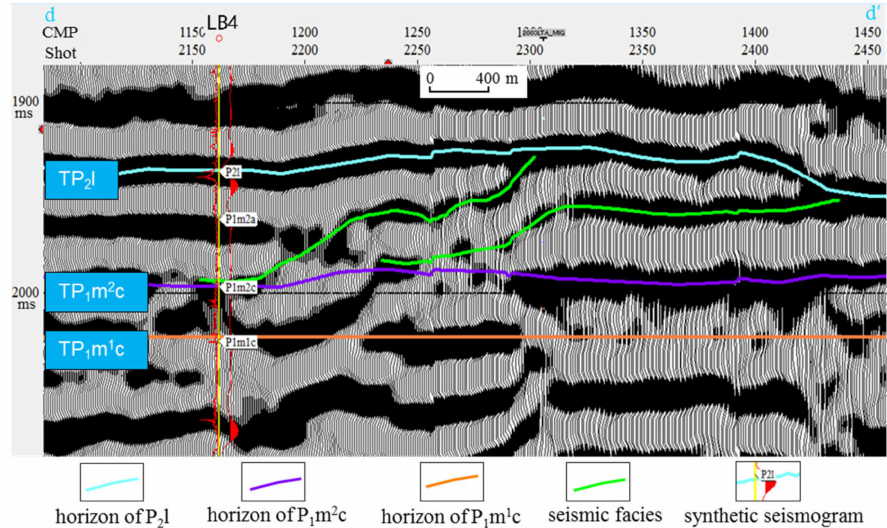
Figure 10. Seismic facies of oblique progradation (seismic line through Well